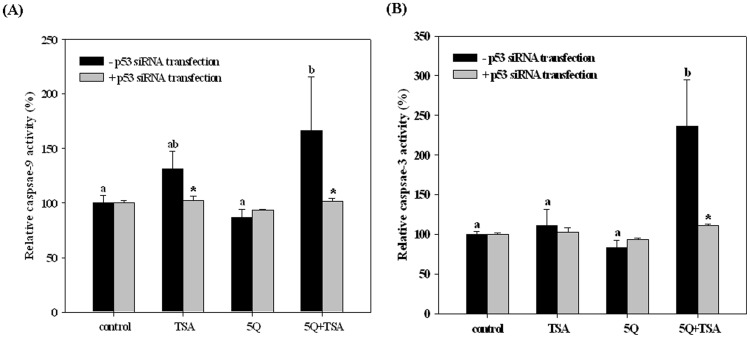
Effects of trichostatin A (TSA) alone or in combination with quercetin on caspase-9 (A) and caspase-3 activity (B) in A549 cells with or without p53-silencing.The A549 cells were transfected with or without p53 siRNA before incubation with 25 ng/mL TSA alone or in combination with 5 µM quercetin (5Q) for 24 h. Values (means ± SD, n = 3) among the groups without p53-silencing not sharing a common letter (a-c) are significantly different (p<0.05). Values in p53-silenced cells with asterisks (*) are significantly different from in p53-normal cells with the same treatment (p<0.05).